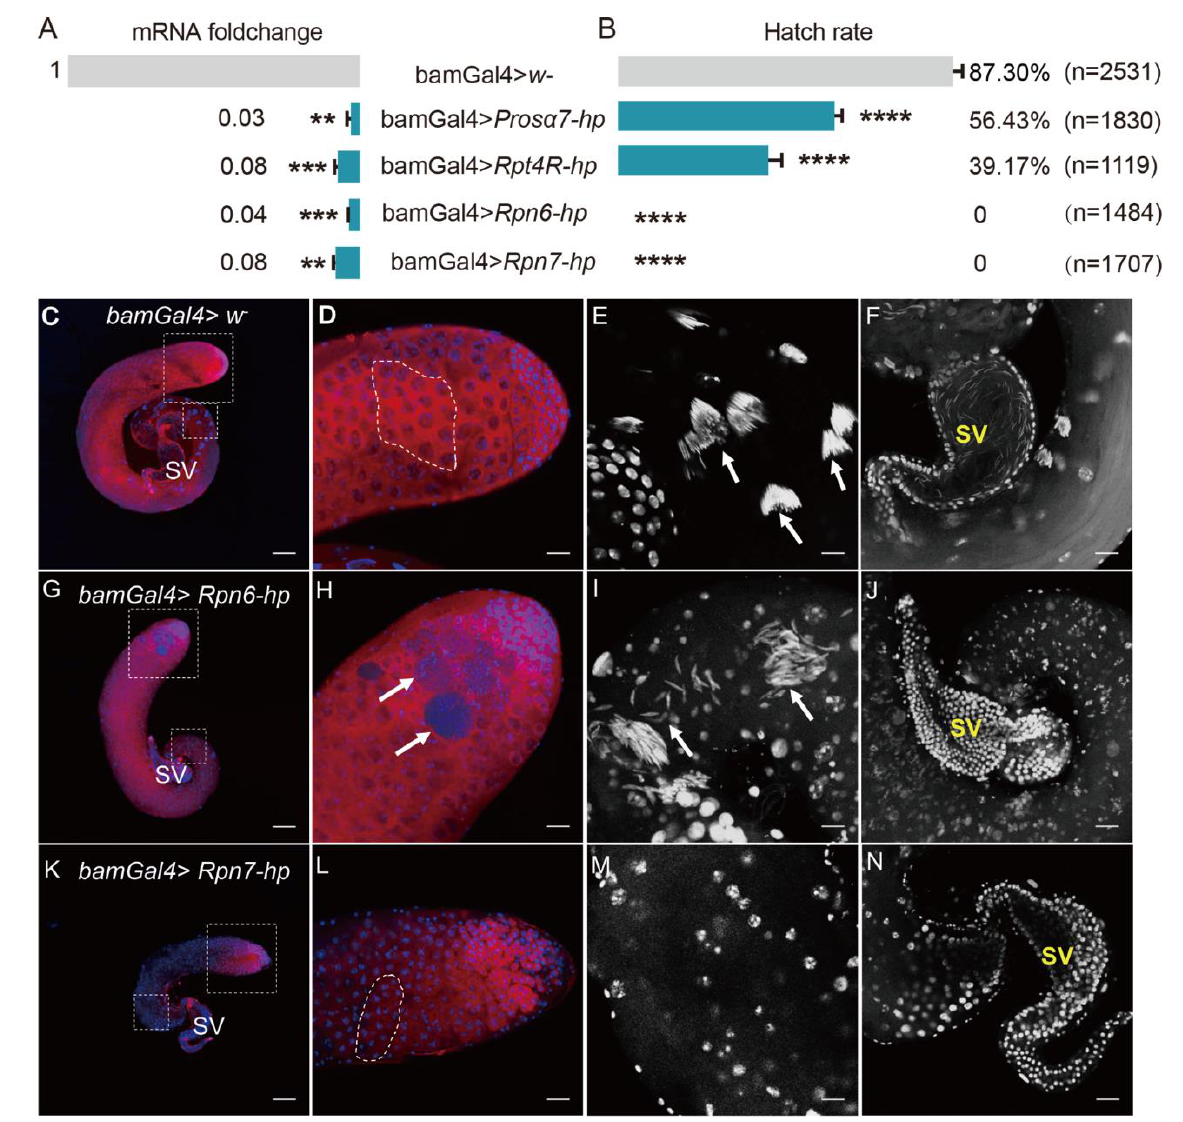
Figure 8. Knockdown of candidate genes in the testis of D. melanogaster impaired male fertility. ( A ) qRT-PCR analyses showed that the four genes were successfully knocked down driven by bamGal4 in fly testes. ( B ) Hatch rates of eggs derived from the crosses with the four gene knockdown males. bamGal4 > w – males were used as control. ** p < 0.01; *** p < 0.001 ; **** p < 0.0001. ( C – N ) Fly testes stained with Vasa antibody and DAPI. ( C – F ) Control testis; ( G – J ) Rpn6 knockdown testis; ( K – N ) Rpn7 knockdown testis. ( C , G , K ) Whole images of testes; ( D , H , L ) Apical regions of fly testes. Germ cells were stained with Vasa antibody (red); Nuclei were stained with DAPI (blue). ( E ) The spermatid nuclei were tightly bundled (white arrows) in the base region of the control testis, but the spermatid nuclei were scattered or disorganized (white arrows) in Rpn6 knockdown testis ( I ) or were not observed in Rpn7 knockdown testis ( M ). DAPI staining shows the seminal vesicle full of mature sperms with needle-like nuclei in control testis ( F ) or the seminal vesicles with no sperms in Rpn6 or Rpn7 knockdown testes ( J , N ). SV: Seminal vesicle. ( D , E , H , I , L , M ) correspond to the dotted box areas in ( C , G , K ), respectively. Dotted frames in ( D , L ) represent the 16-cell stage of germ cells. Scale bars: 100 µ m ( C , G , K ); 25 µ m ( D , F , H , J , L , N ); 12.5 µ m ( E , I , M ).